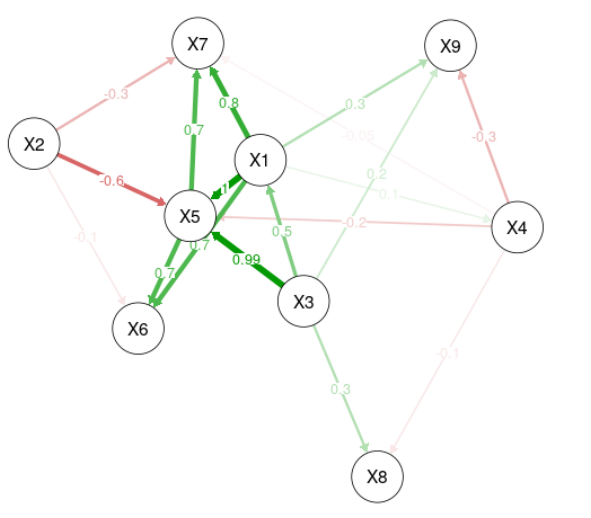
Figure 3. The fuzzy cognitive map of the transport